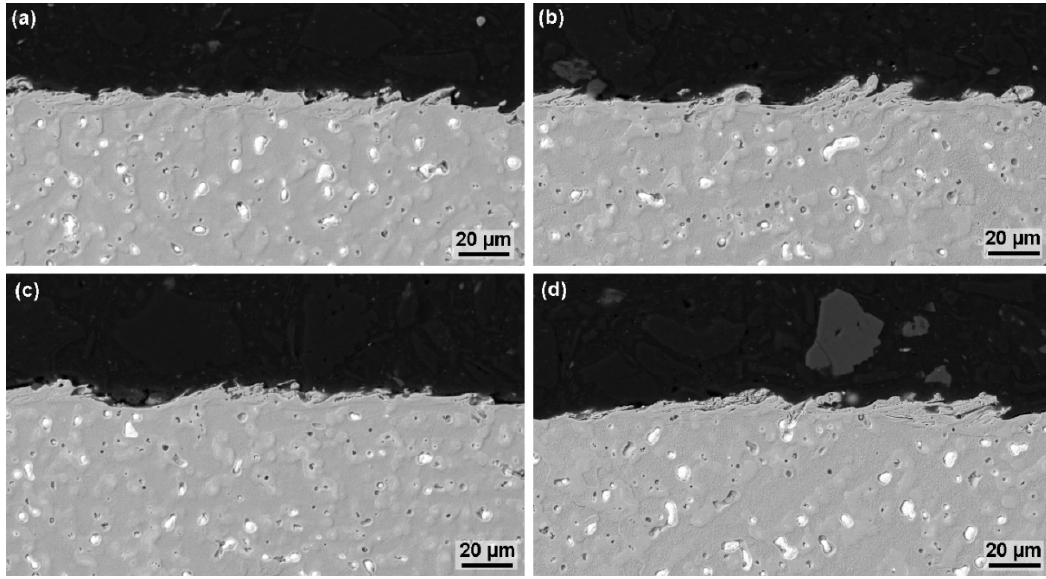
Figure 8. Cross-section of the samples, SEM (BSE) ( a – c ) Samples 20, 21 and 33 having the lowest Ra values of 2.4 µ m, ( d ) Sample 29 with the worst surface quality in terms of topography.